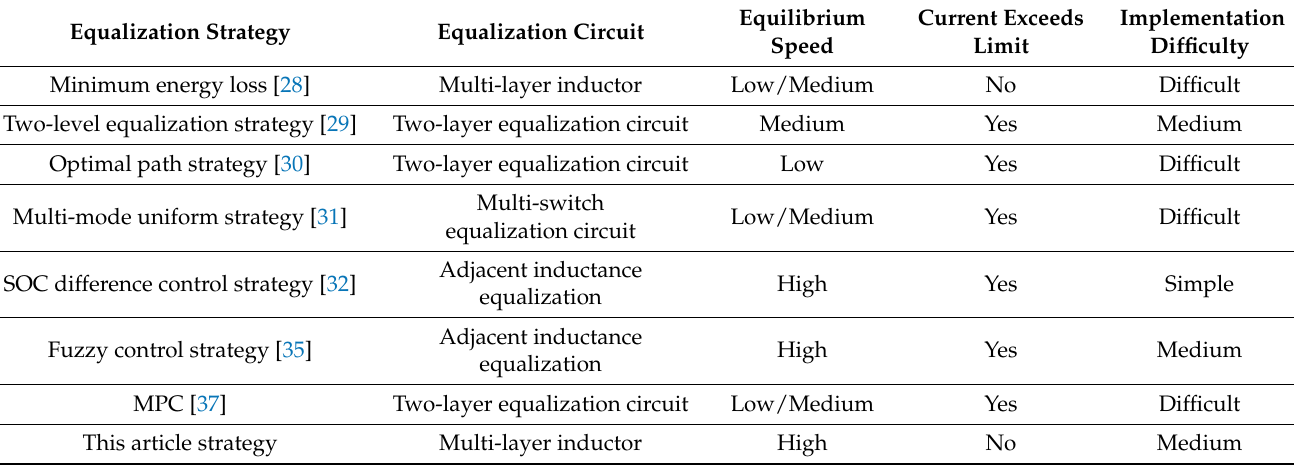
Table 2. Performance comparison of different balancing